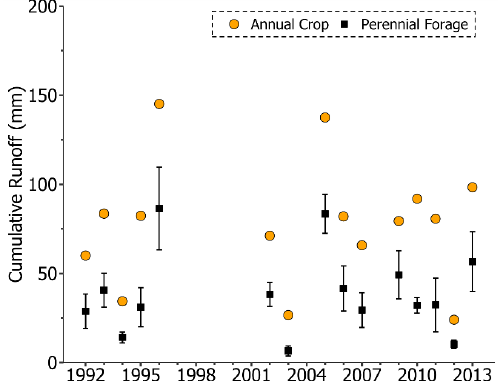
Figure 5. Comparison of annual overland flow between annual crop and forage simulations for the La Salle River subbasin (LS- 05OG008). Error bars indicate the 95% confidence interval of the forage simulation ensemble. The years 1997–2001, 2004, and 2008 were not used for model assessment due to missing data or equip- ment malfunctions.